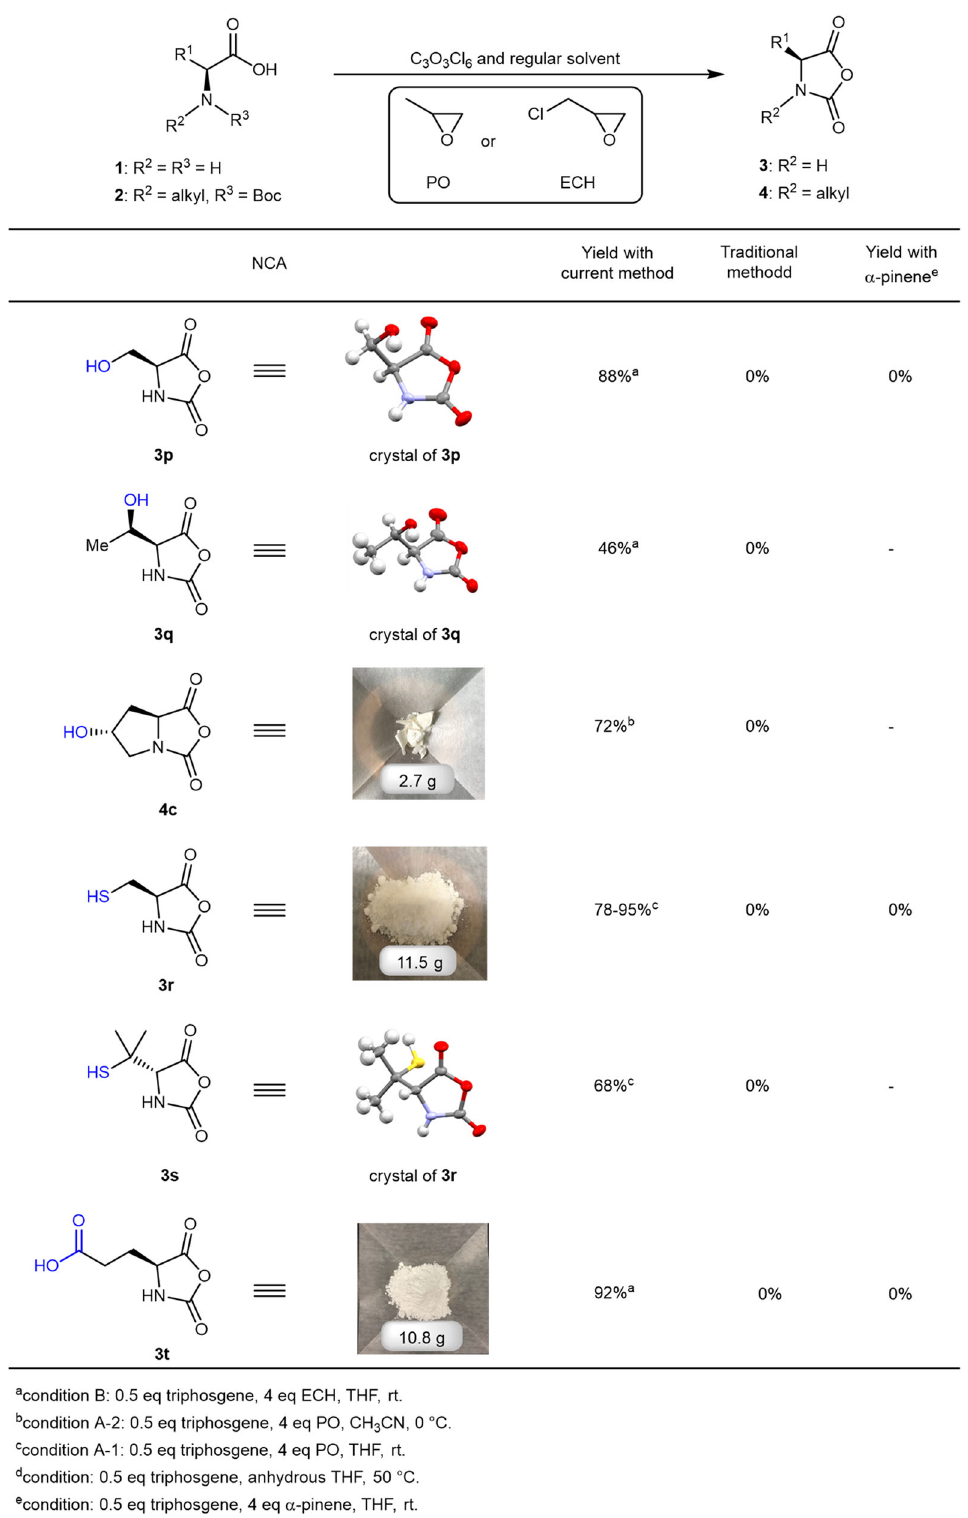
Fig. 4 Synthesis of unprotected NCA. The addition of PO (propylene oxide) or ECH (epichlorohydrin) enables the facile synthesis of challenging NCAs bearing reactive -OH, -SH, or -CO 2 H side